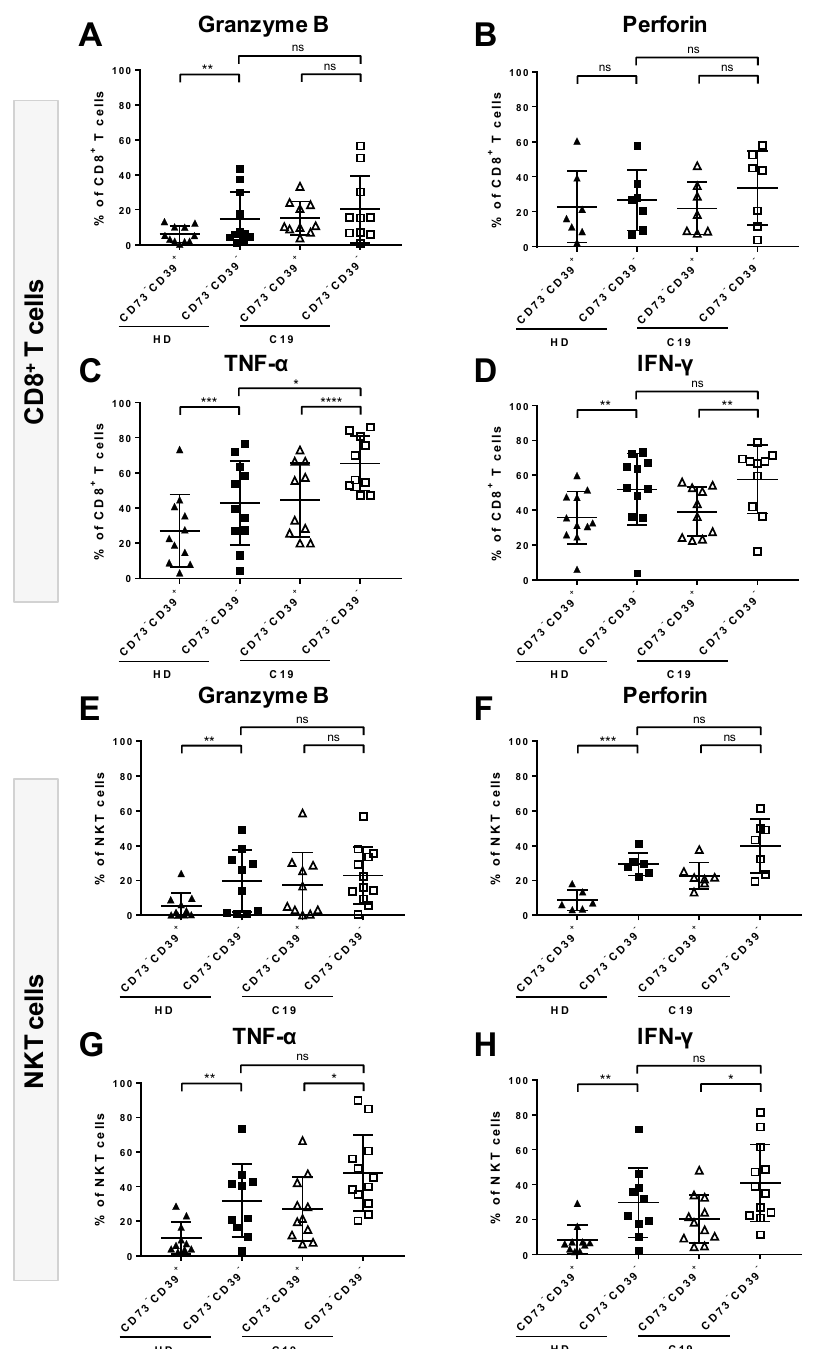
Figure 7. Comparison between the CD39 + CD73 - and CD39 - CD73 - cell subsets for the ability to secrete granzyme B (GrB), perforin, TNF- α and IFN- γ in COVID-19 (C19) and healthy donors (HD). PBMCs of C19 patients and HD were analyzed upon unspecific stimulation. Within CD8 + T cells in C19, the secretion of TNF- α ( C ) and IFN- γ ( D ) was significantly increased in CD73 - CD39 - T cells compared to their CD73 - CD39 + counterparts. In HD, in addition to TNF- α ( C ) and IFN- γ ( D ), the proportion of GrB ( A ) secreting cells was significantly elevated among CD73 - CD39 - cells. Within NKT cells in C19, GrB ( E ) and perforin ( F ) were moderately increased while the secretion of TNF α ( G ) and IFN- γ ( H ) was significantly elevated on the CD73 - CD39 - subset compared to the CD73 - CD39 + subset. In HD, the secretion of all four tested functional molecules was elevated among CD73 - CD39 - T cells. Data are shown as mean ± SD.